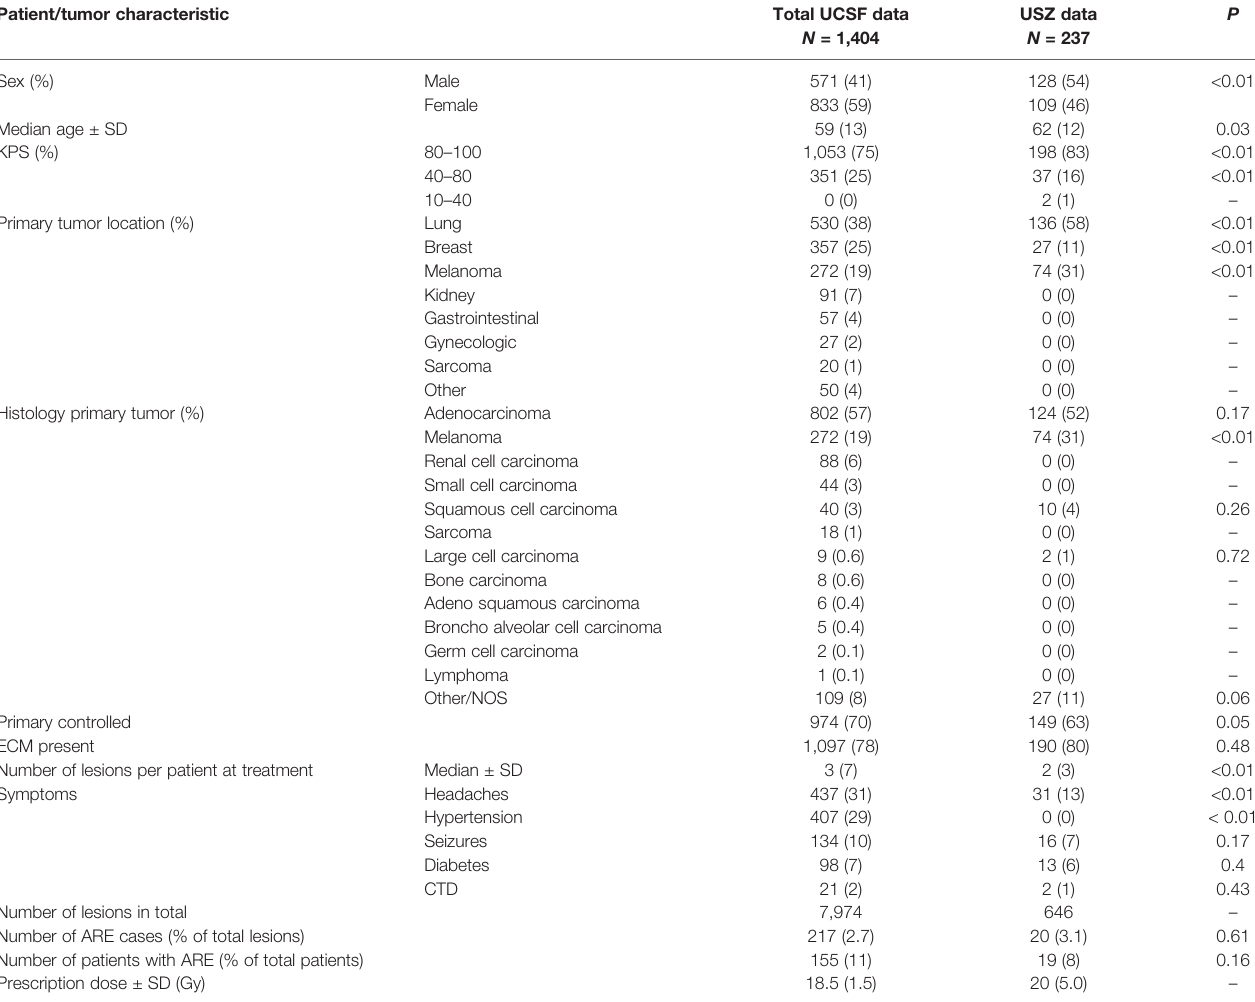
TABLE 1 | Patient characteristics of University of California — San Francisco (UCSF) and University Hospital Zurich (USZ)